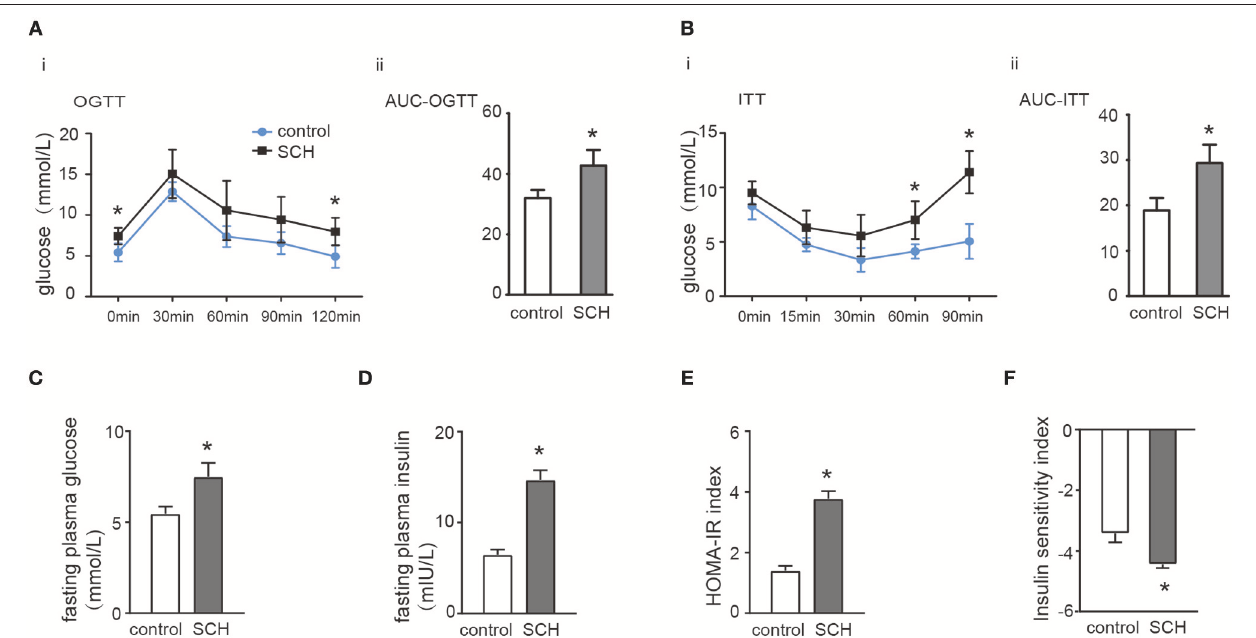
FIGURE 2 | SCH mice exhibited abnormal glucose metabolism and IR. Male C57/BL6 mice were given methimazole (MMI, 0.08 mg/kg · BW · d, SCH group) or a corresponding volume of vehicle (control group). (A) Oral glucose tolerance test (OGTT) was implemented to detect glucose tolerance at the 13th week of administering MMI to mice in the drinking water. (B) Insulin tolerance test (ITT) was implemented to assess insulin-stimulated glucose disposal at the 14th week of administering MMI to mice in the drinking water. (C) The fasting plasma glucose level was assayed at the 14th week ( n = 4–6). (D) The fasting plasma insulin level was